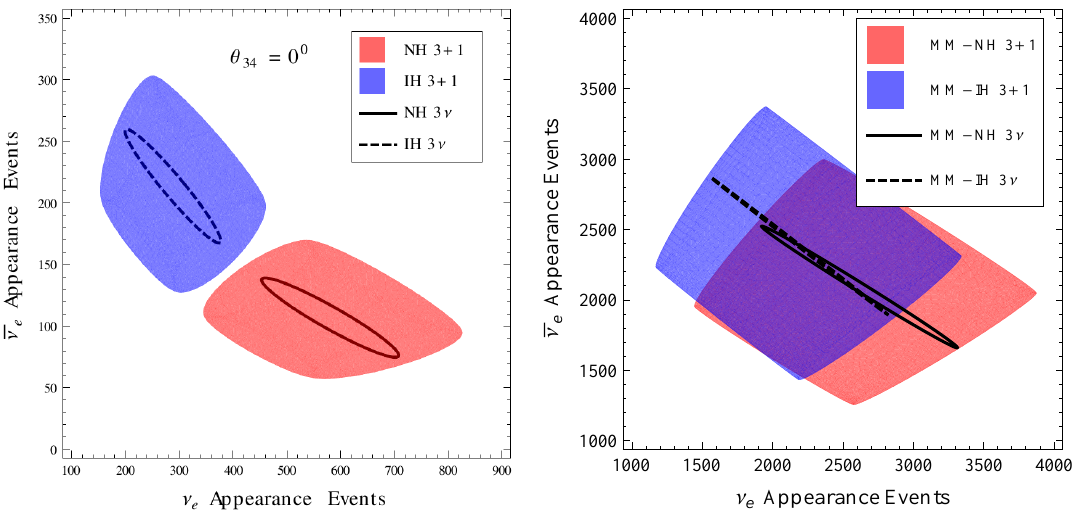
Figure 1. The colored blobs in the left ( right ) panel represent the bi-event plots for DUNE (T2HK) in the 3 + 1 scenario. The regions are obtained by varying the CP-phases δ 13 and δ 14 in the range [ − π , π ] . The black curves represents the 3-flavor ellipses. In this case, there is only one running parameter, the CP-phase δ 13 . Both figures are obtained for maximal θ 23 mixing. This is explicitly indicated only in the right panel as “MM” in the legend. Figures taken from [45] ( left ) and [50] ( right ).